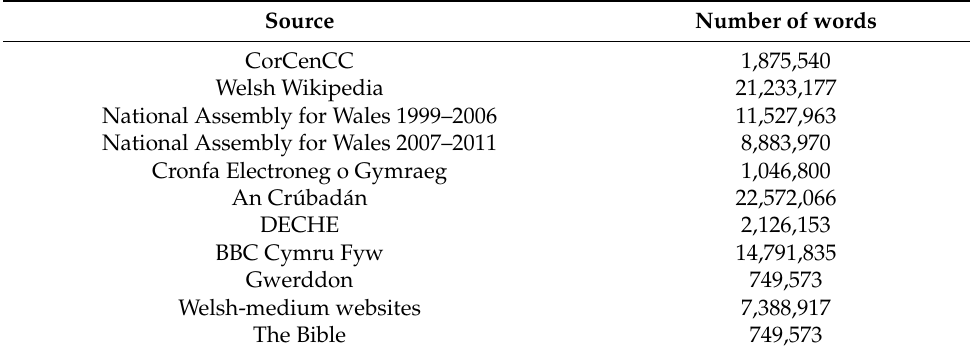
Table 1. Data sources used to collect the training